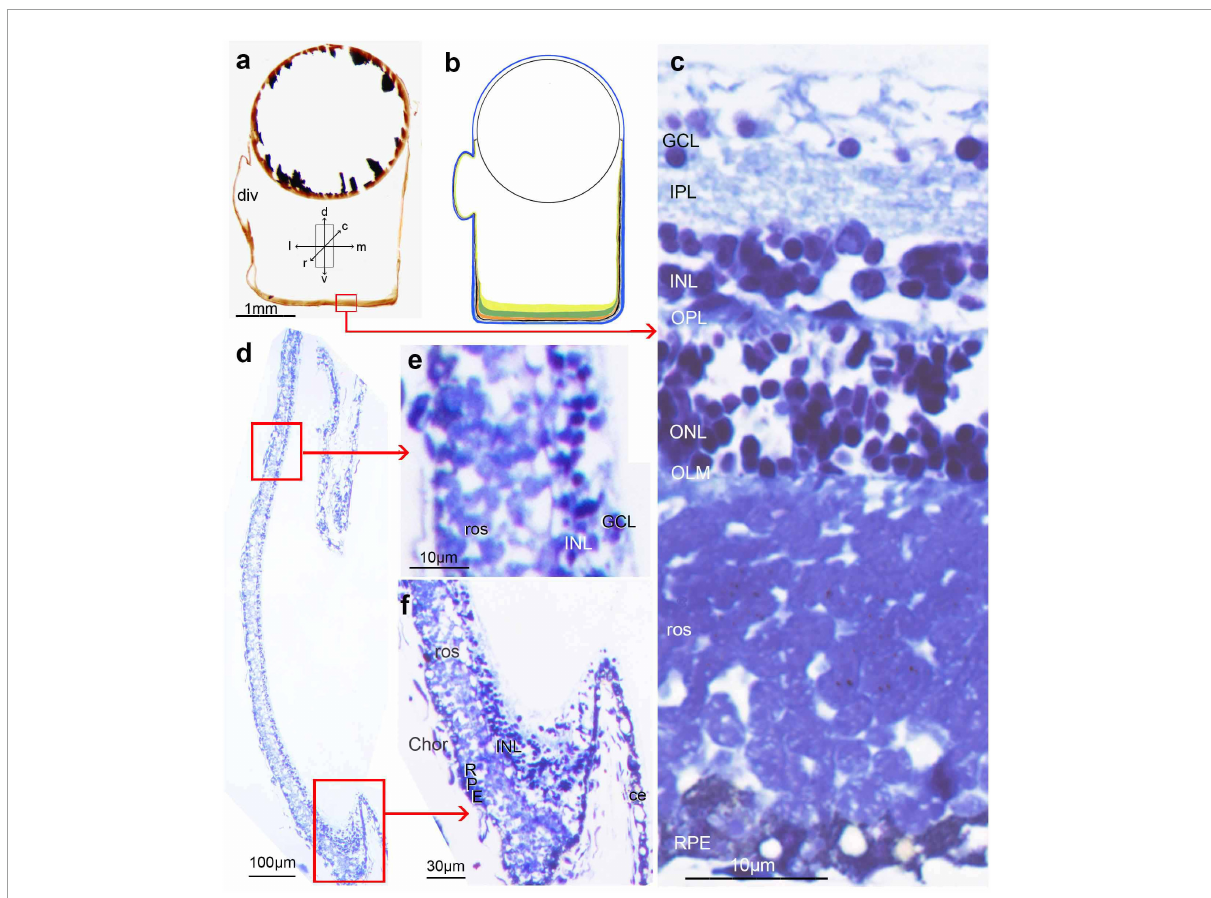
FIGURE7 Small Macropinna microstoma : (a) approximately transverse thick section of tube eye (all but the peripheral lens was lost during sectioning); (b) schematic drawing of tube eye with diverticulum, colour coded as Figure 1 ; (c) semithin radial section of the main retina; (d) radial semithin section of the diverticulum; (e) radial section of the central retina of the diverticulum; (f) semithin section of the ventral area of the diverticulum with transition to the tube eye wall, where the diverticular retina changes to a ciliary epithelium. The orientation arrows in panel (a) are applicable to all panels but see Materials and Methods for comments on deviations from the transverse plane in histological sections. All images in this figure came from an animal of SL 32